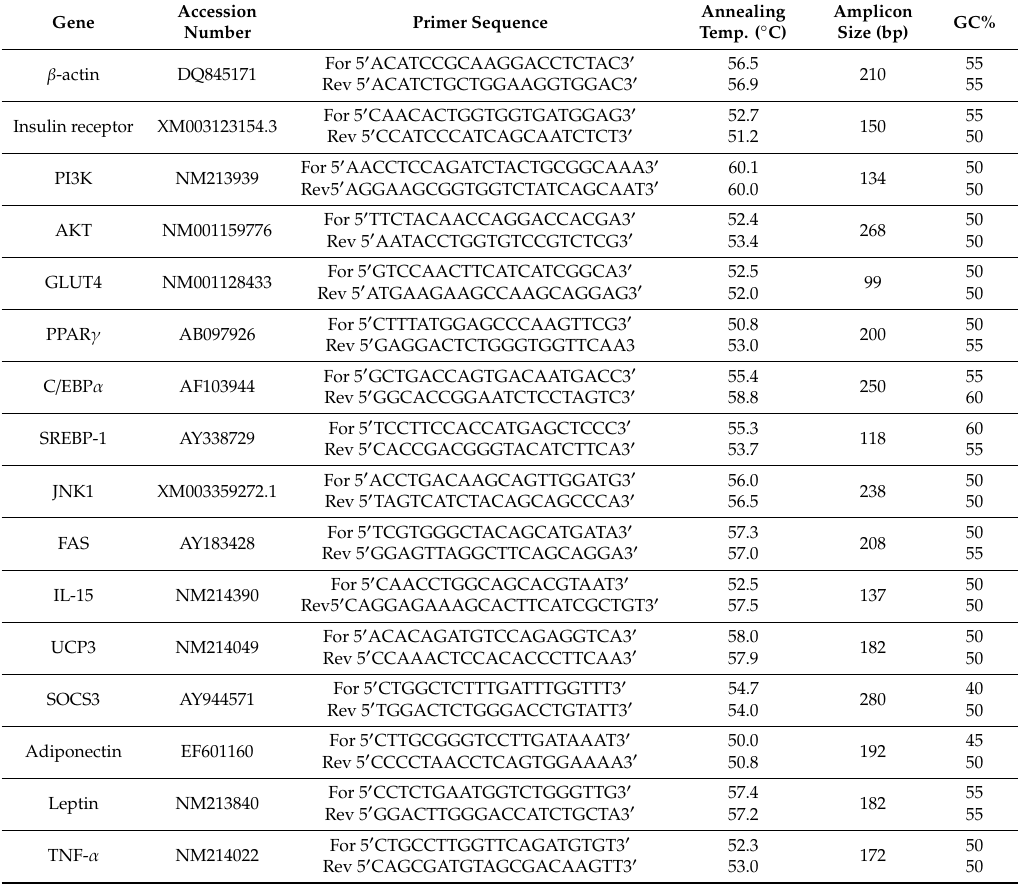
Table 1. List of primers used for pig tissue gene